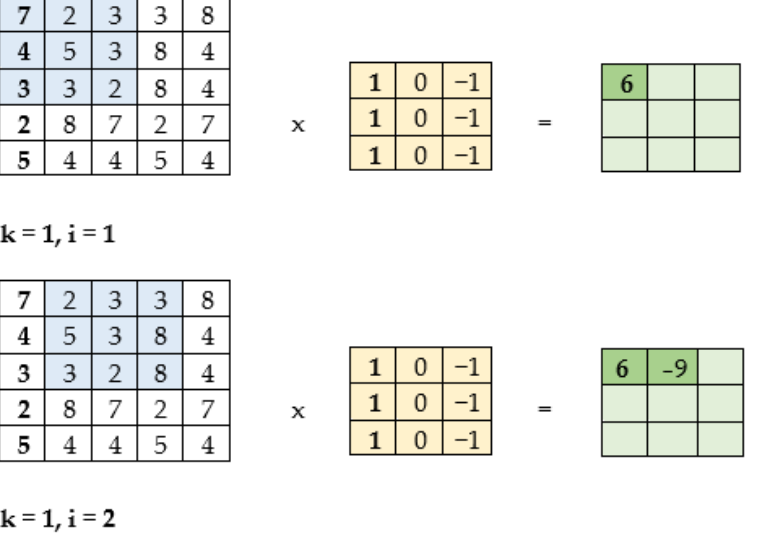
Figure 3. An example of the operation of convolution for image processing with the parameter “ stride ” = 1.